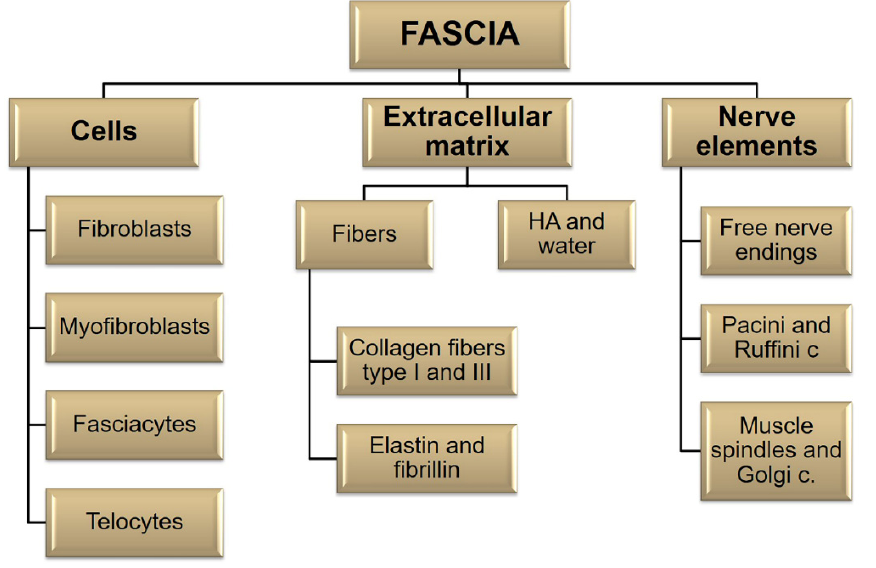
Figure 2. Schematic representation of the various fascial elements.